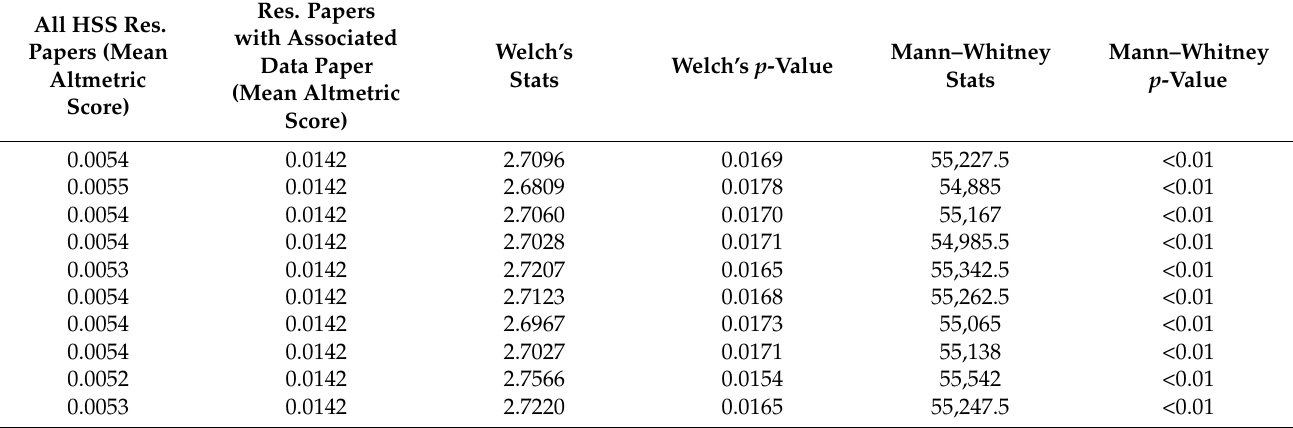
Figure 12. Comparison between research papers with an associated data paper and all HSS research papers (2015–2022): Altmetric scores. Table 7. Welch’s t -test and Mann–Whitney U -test results: mean Altmetric score of research papers with an associated data paper and all HSS research papers between 2015 and 2022, at each random sampling of the latter. All HSS Res.